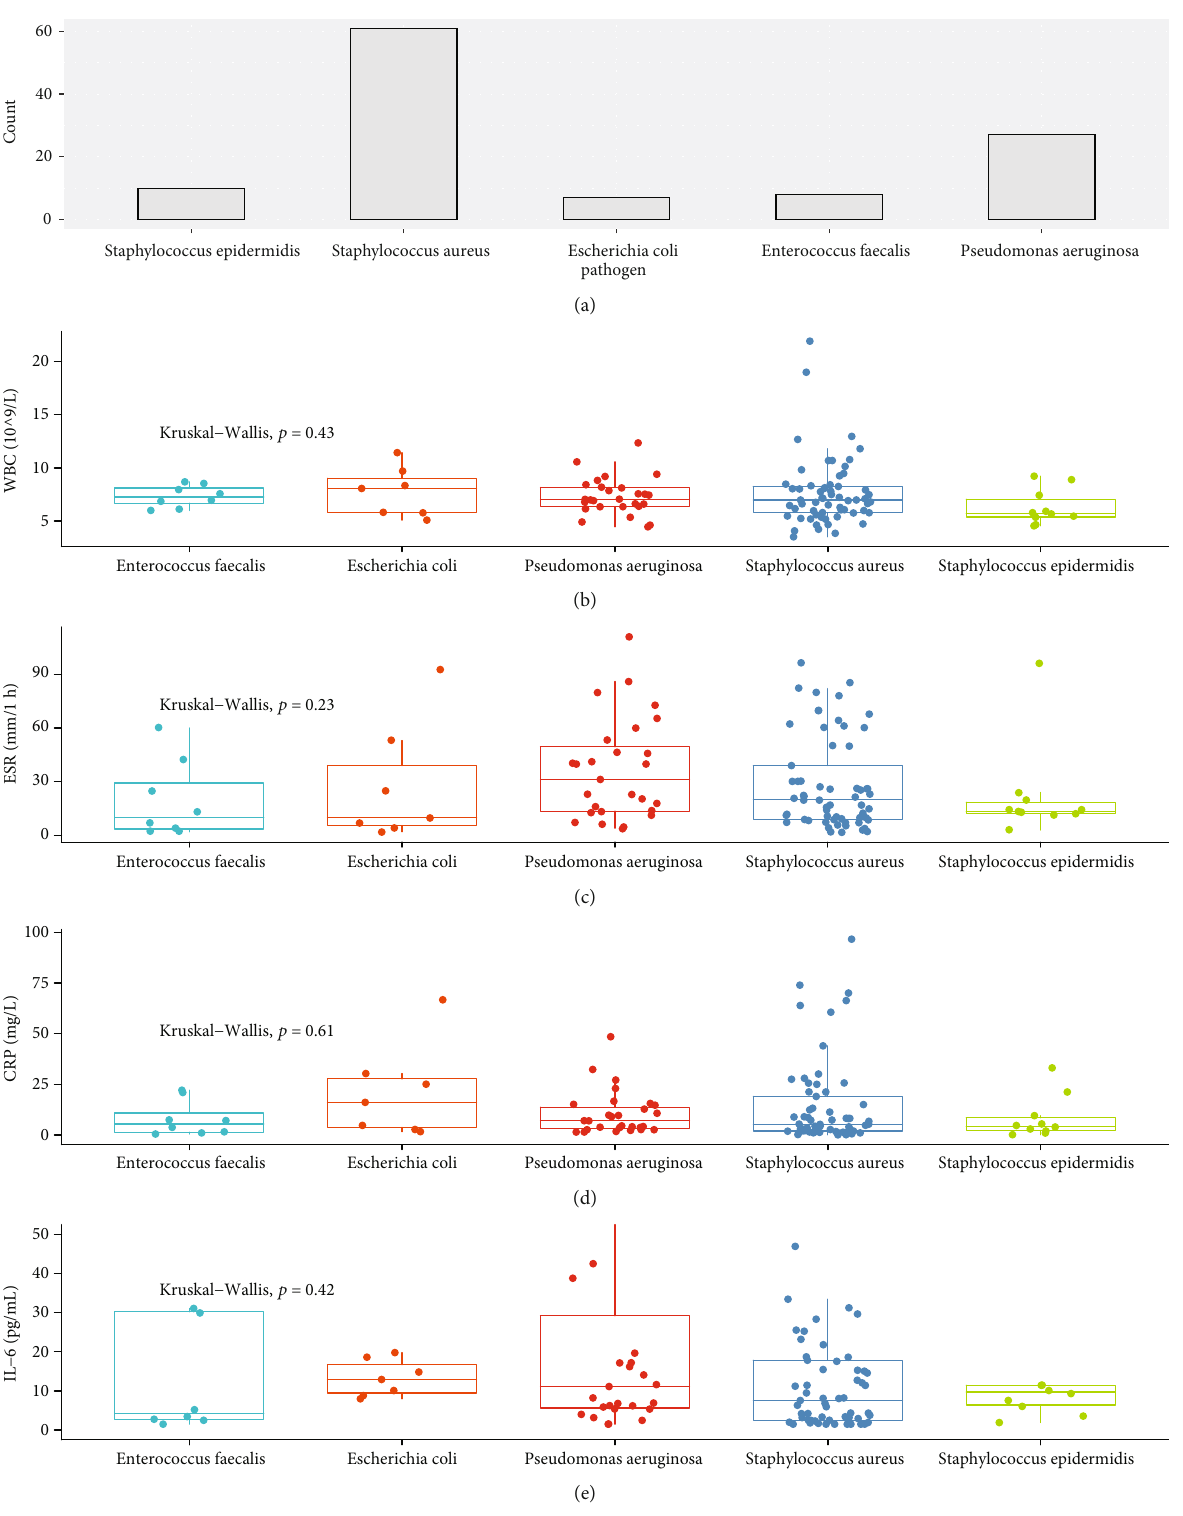
Figure 4: Plots of in fl ammatory biomarkers ’ levels among di ff erent types of pathogenic bacteria: (a) the top fi ve pathogens accounting for monomicrobial infection; (b) WBC; (c) ESR; (d) CRP; (e)